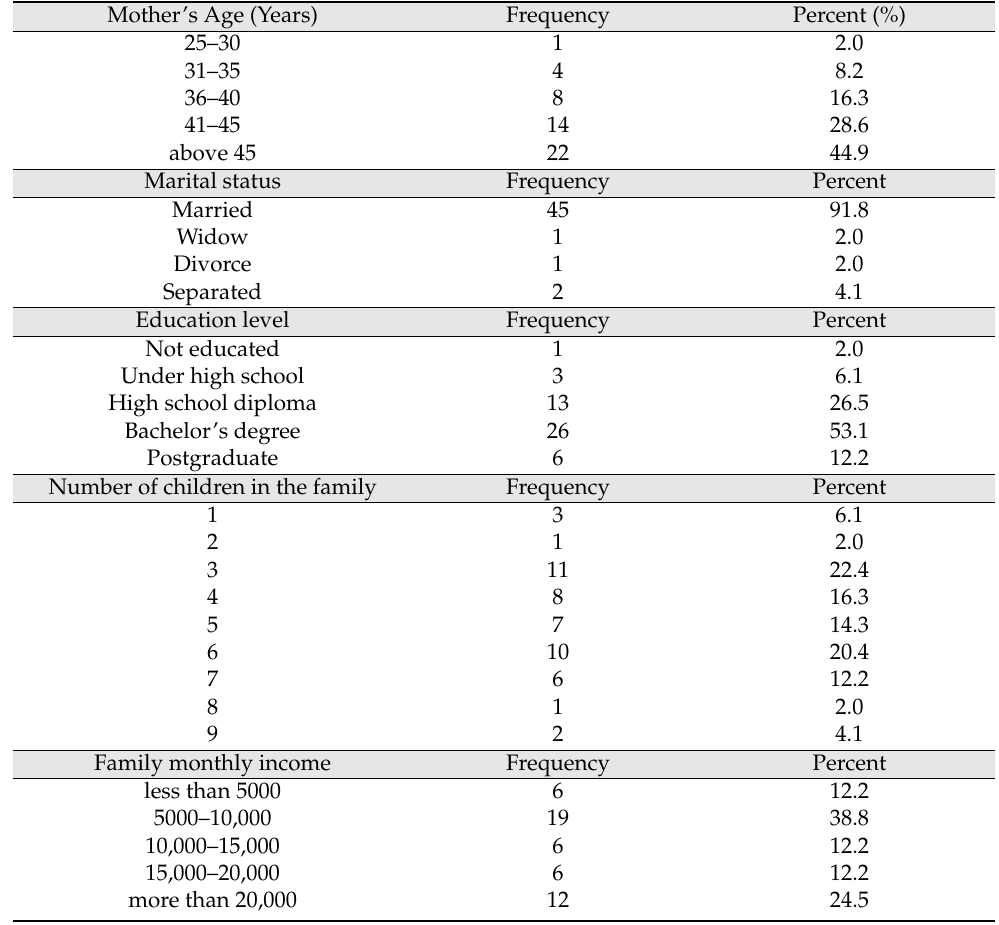
Table 1. Descriptive information about mothers of